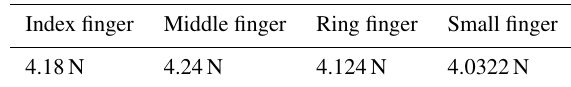
Table 5. The cable tension force (in N) for each